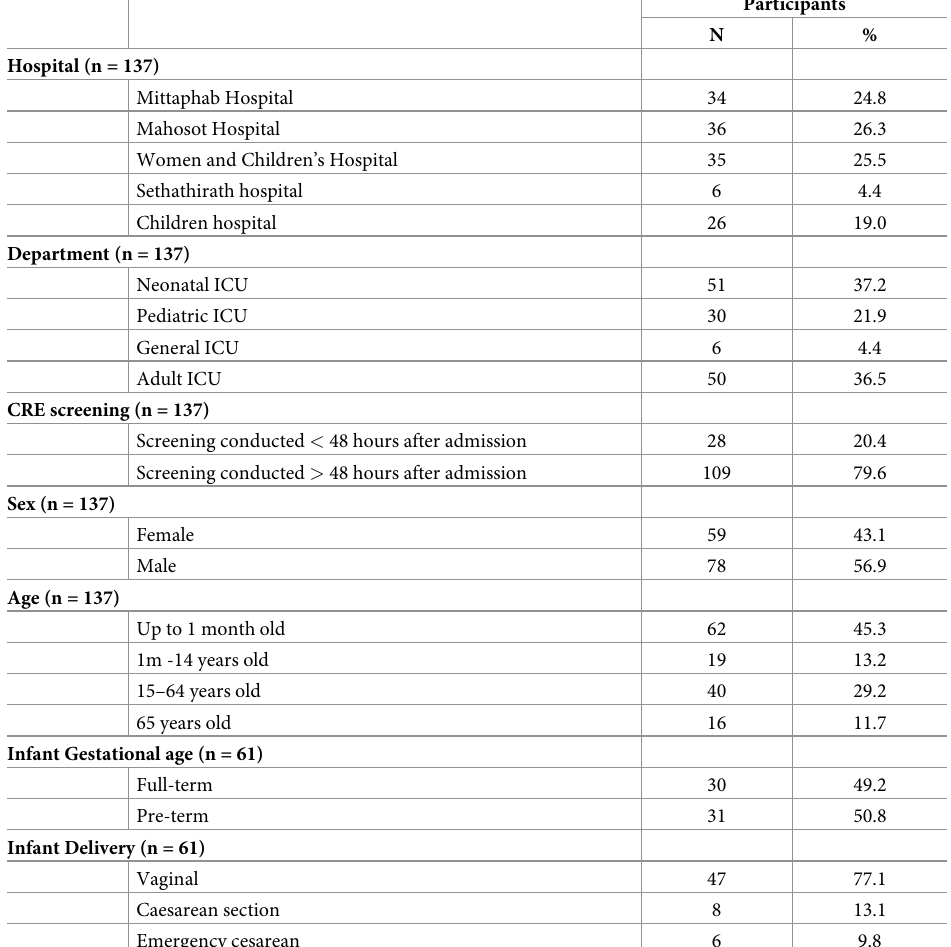
Table 1. Demographic and clinical characteristics of the study